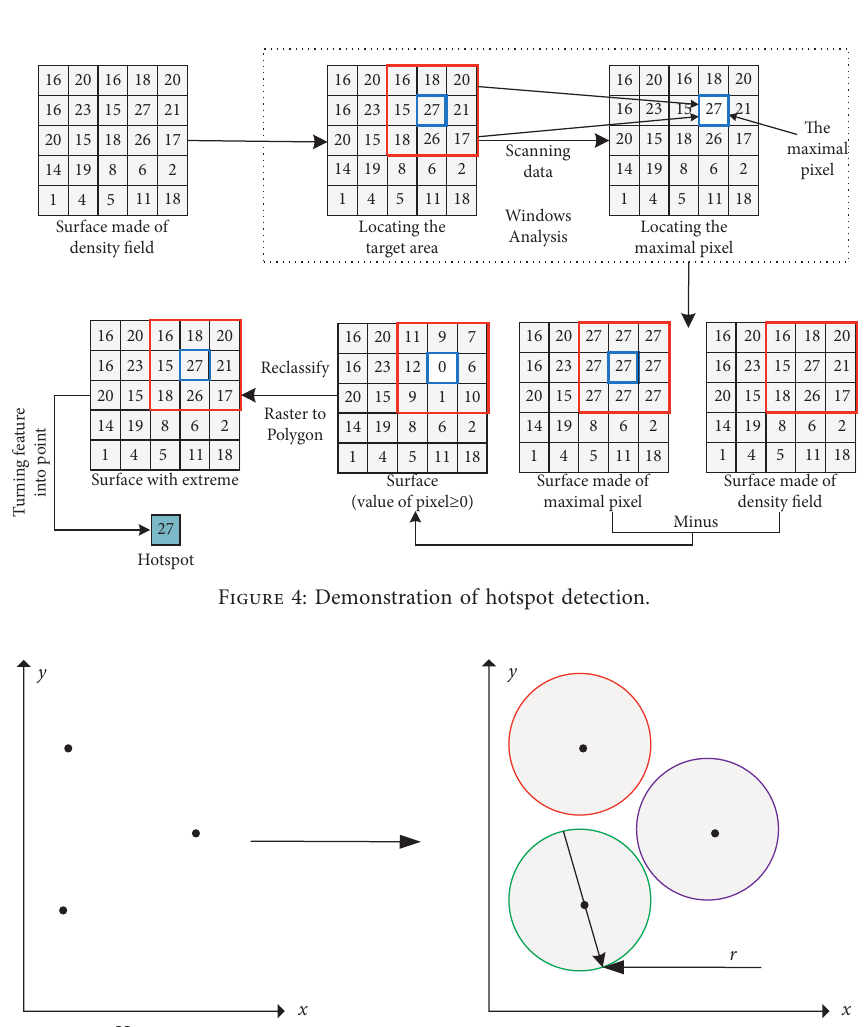
Figure 3: The flowchart of hotspot